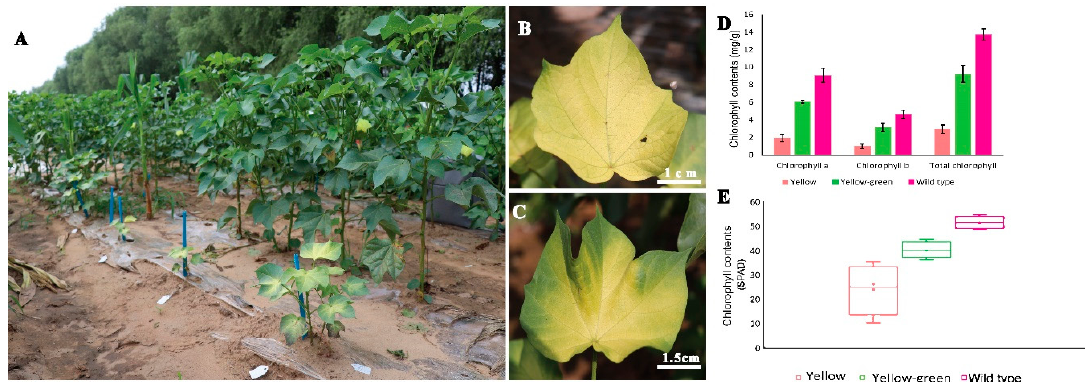
Figure 6. Yellow and yellow-green leaf mutants with reduced chlorophyll contents ( A ) yellow and yellow-green leaf mutants with reduced plant height as compared to wild type plants, ( B ) Pure yellow leaf color, ( C ) yellow-green leaf color, ( D ) chlorophyll contents of wild type, yellow and yellow-green leaf mutants, ( E ) chlorophyll contents of wild type, yellow and yellow-green leaf mutants using SPAD meter.